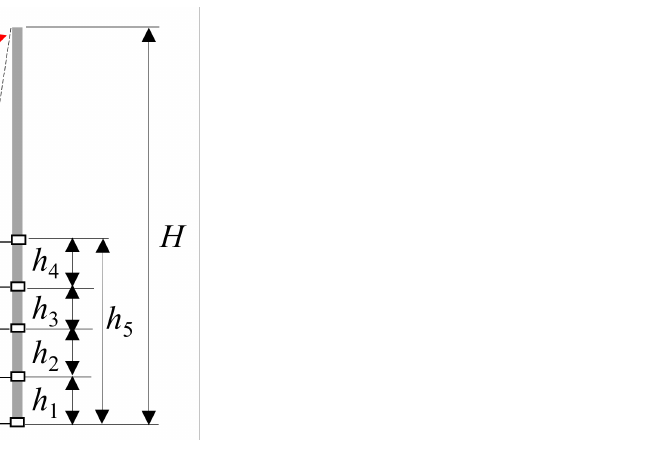
Figure 3. Schematic of the linear dynamic pressure distribution on the right vertical wall with the assumption that P = 0 at the elevation equal to that of initial impoundment depth h 0 , h 1 = h 2 = h 3 = h 4 = 35 mm, H = 300